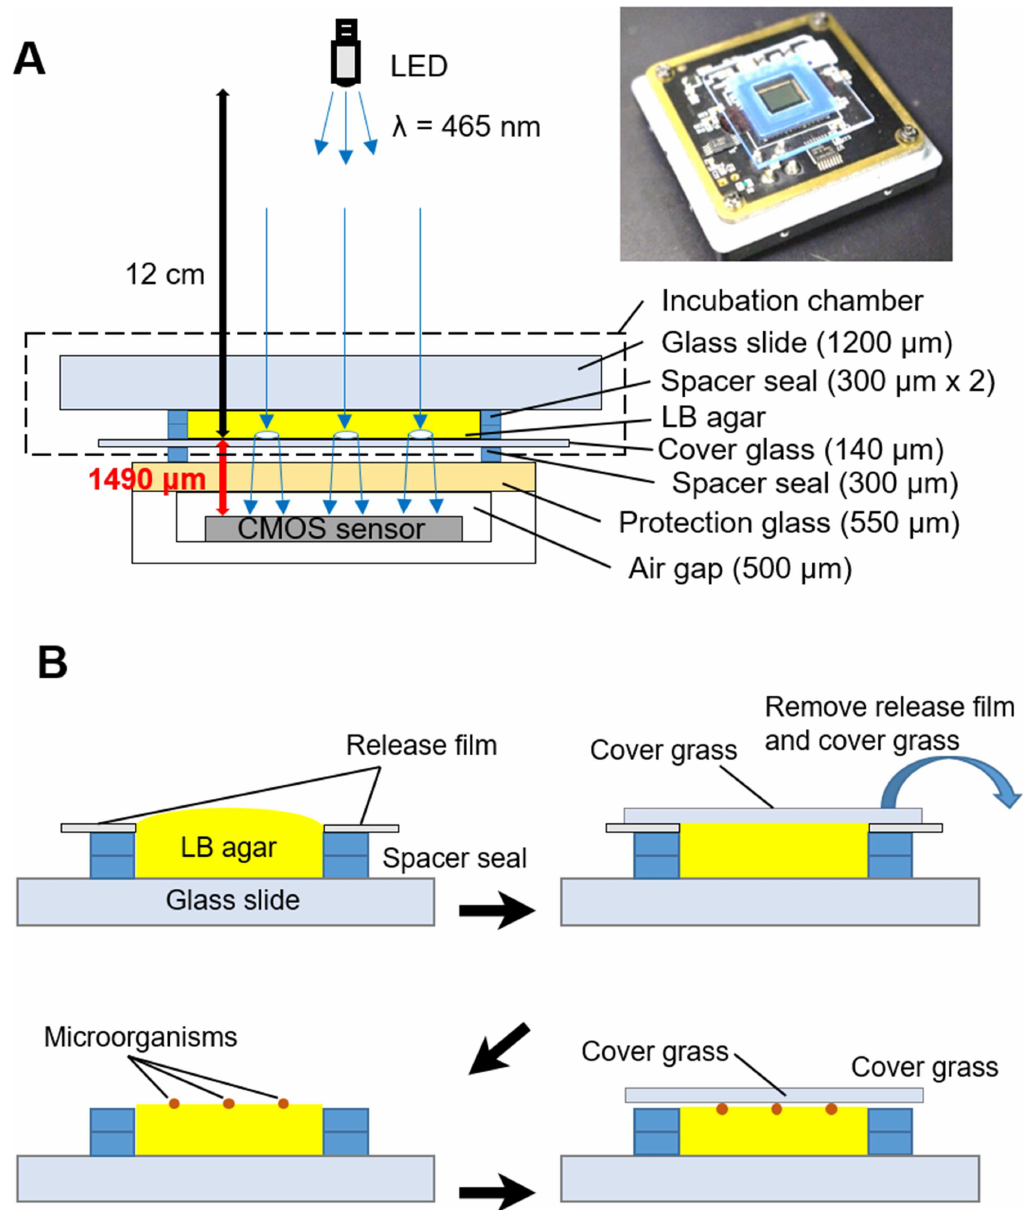
Fig 1. The lensless microcolony imaging systemdeveloped in this study. (A) A schematic diagram and photograph of the imagingsystem. Thickness of each componentis described. (B) The schematic procedureof preparation of the